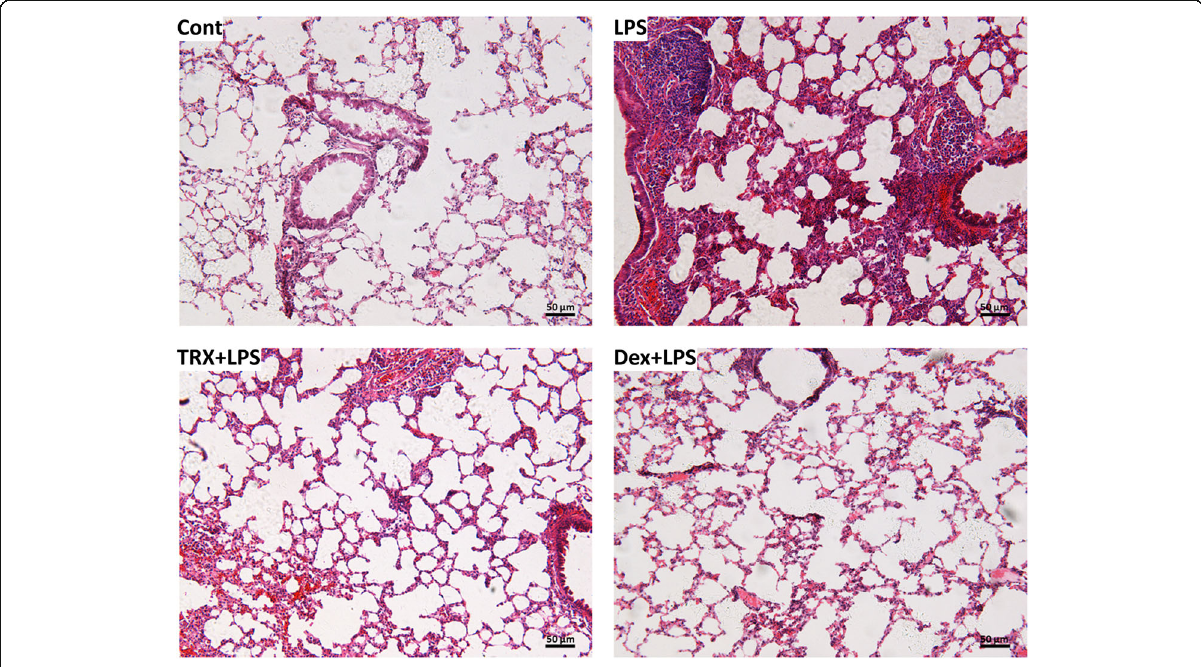
Fig. 4 The effect of TRX on the microscopic appearances of lung from LPS-induced ALI mouse; Cont: a control group, LPS: LPS group, TRX + LPS: LPS + TRX (150 mg/kg) group, Dex + LPS: LPS + Dex (5 mg/kg) group. Histopathological sections were stained by H.E. Original magnification ×